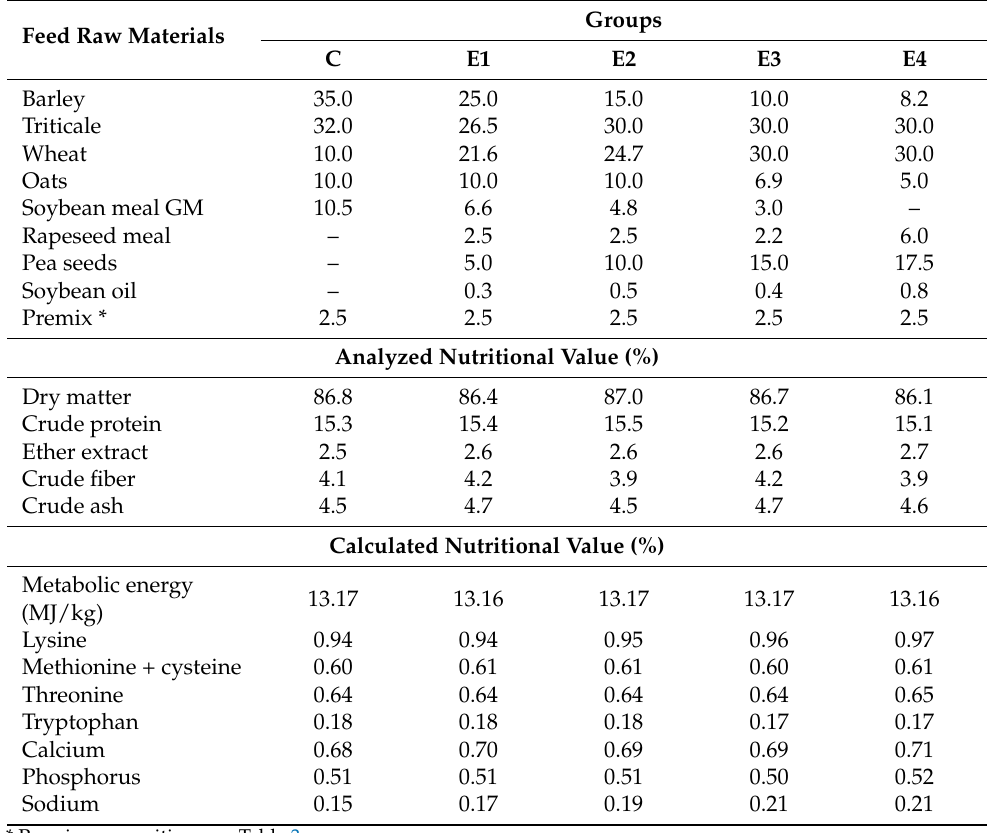
Table 4. Composition of feed mixtures at stage II of fattening